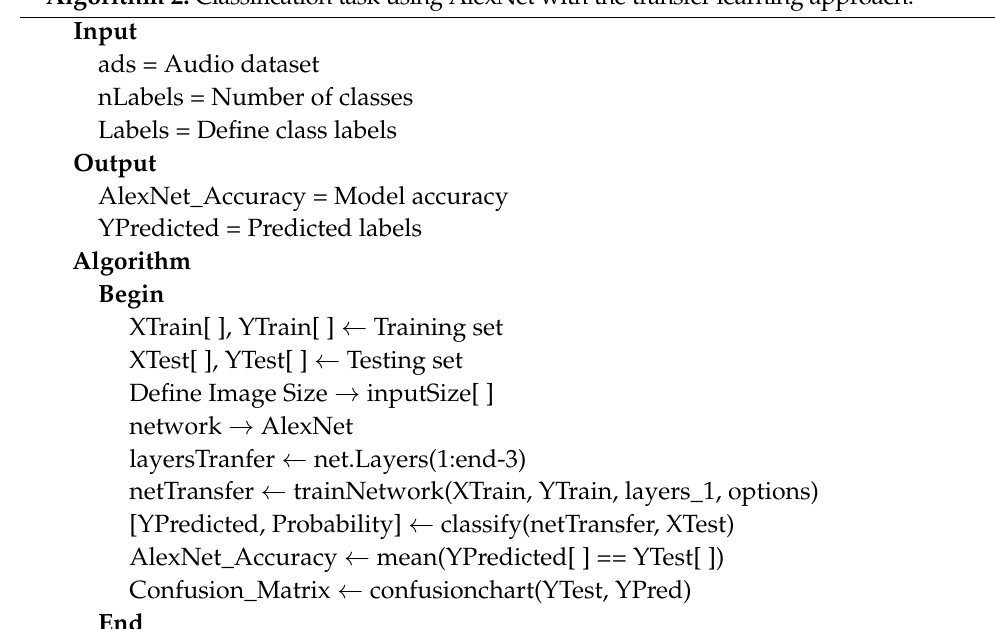
Algorithm 2: Classification task using AlexNet with the transfer learning approach.